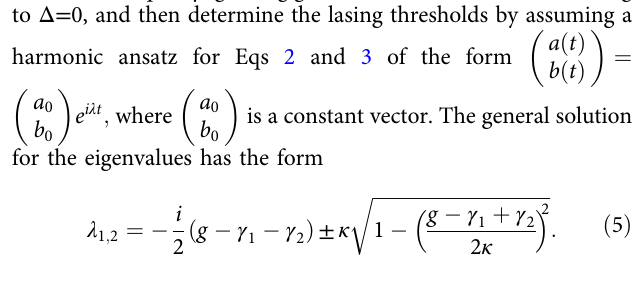
ffiffiffiffiffiffiffiffiffiffiffiffiffiffiffi p κ 2 (cid:3) g 2